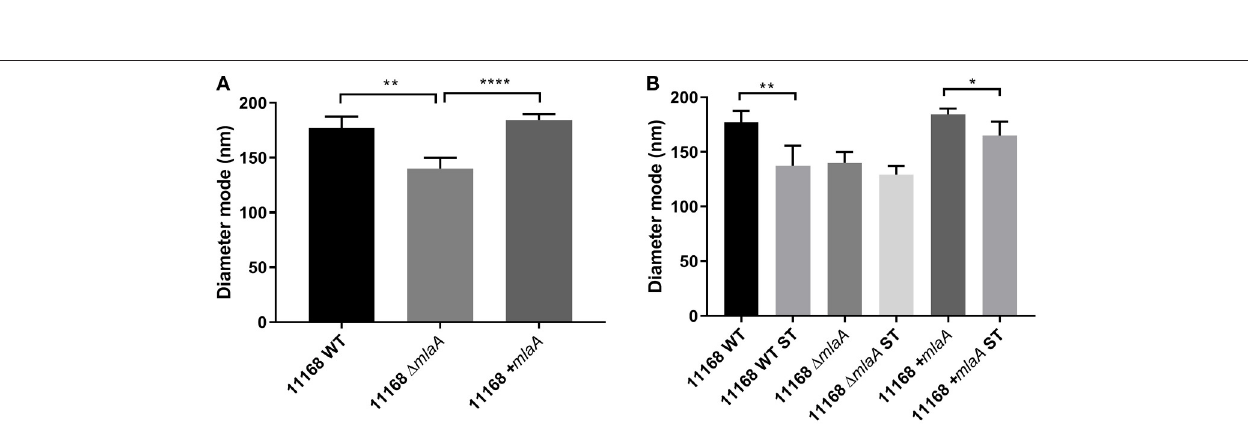
FIGURE 6 | Mutation of mlaA or ST exposure increase OMV particle numbers not OMV size. OMVs were isolated from late-log phase C. jejuni cultures grown in Brucella broth either in the presence or absence of 0.2% (w/v) ST. OMV preparations from cultures of C. jejuni wild-type, mlaA mutant, and complement strains of equivalent OD 600 values were sized by nanoparticle tracking analysis using a PMX 110 ZetaView instrument. (A) OMV mode diameter, (B) OMV compared to ST-OMV mode diameter. * p < 0.05; ** p < 0.01; **** p < 0.0001.